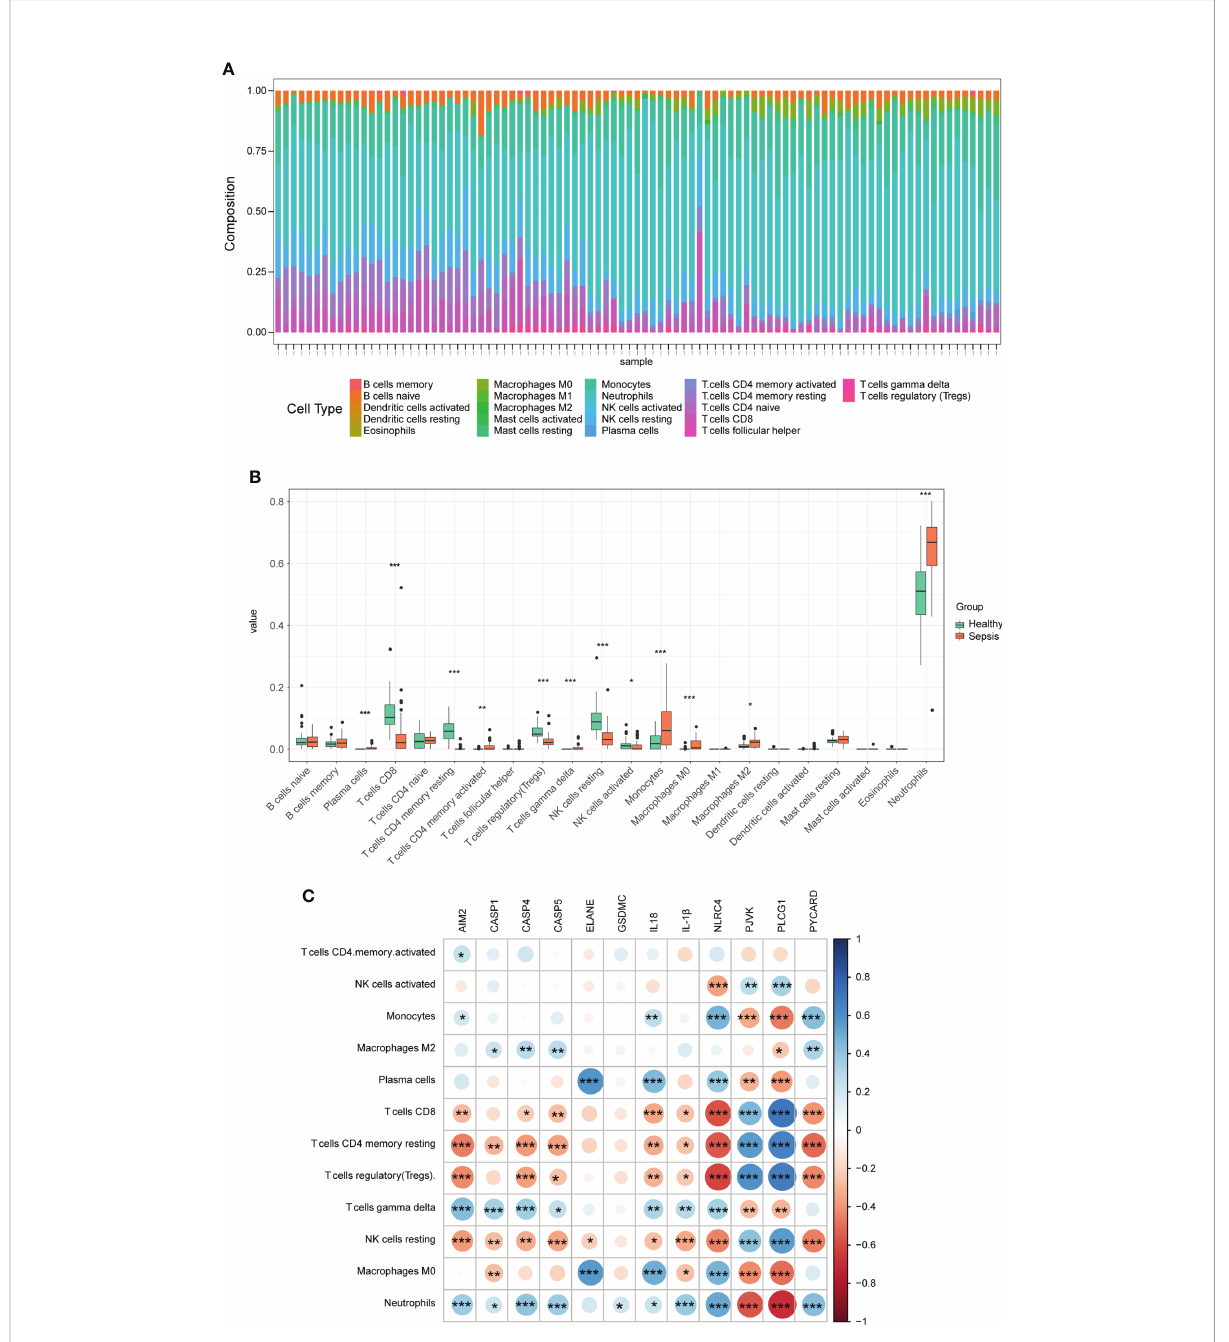
FIGURE 4 Immune in fi ltration between sepsis and healthy controls. (A) The box-plot diagram demonstrates the composition of immune cells in each sample. (B) The difference in immune in fi ltration between sepsis and healthy controls. (C) The correlation heatmap shows the relationship between DEPRGs and immune cells. * p < 0.05, ** p < 0.01, *** p < 0.001. DEPRGs, differentially expressed pyroptosis-related